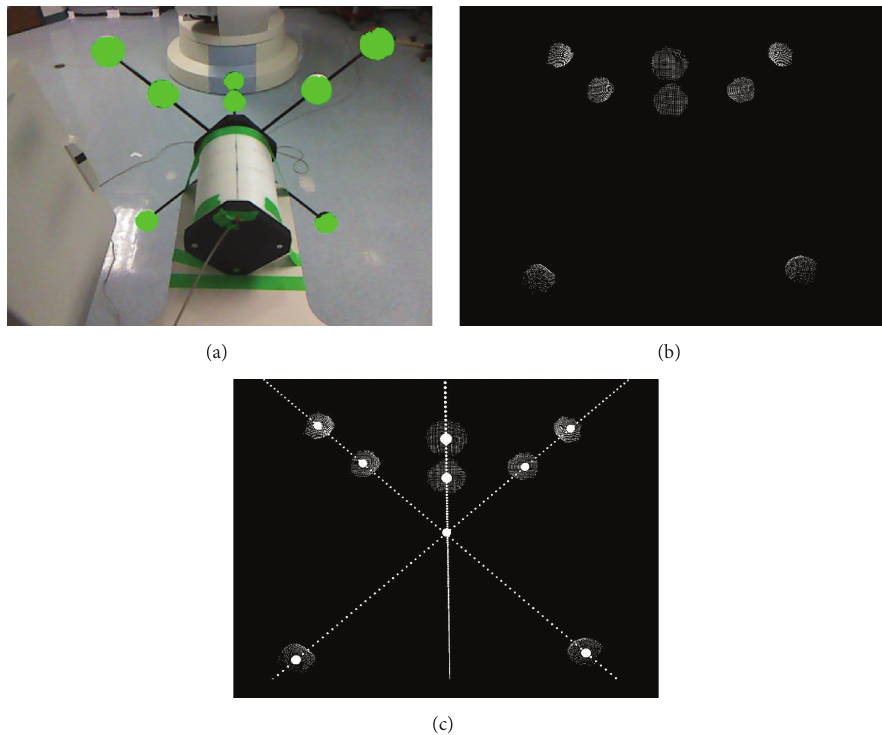
Figure 5: (a) The green areas visualize the resulting segmentation in the RGB image. (b) Surface points of the segmented pixels. (c) Sphere centers and subsequently the coordinate axes and origin are fitted to these